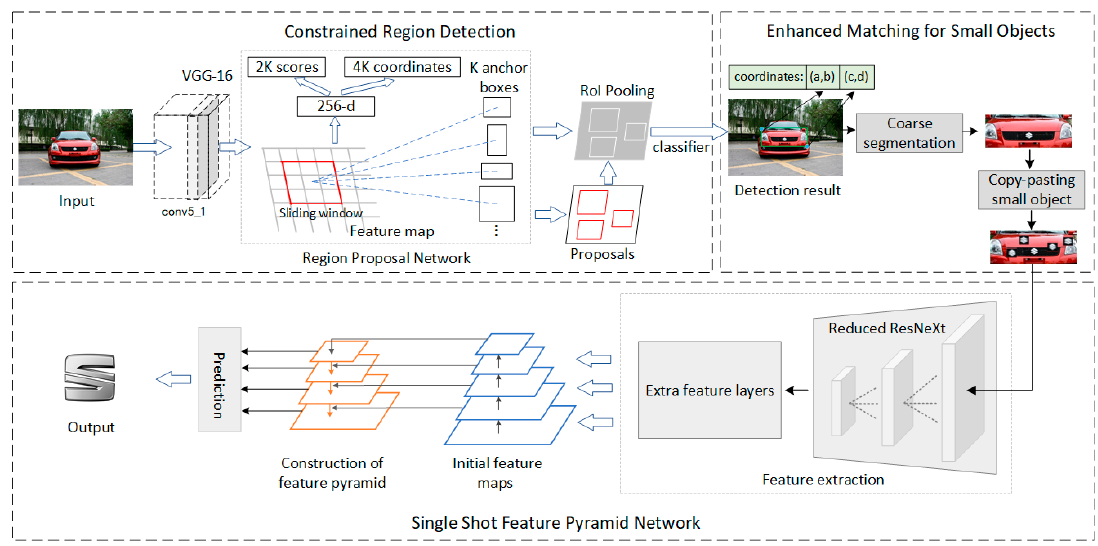
Figure 1. Framework of proposed method for vehicle logo recognition.